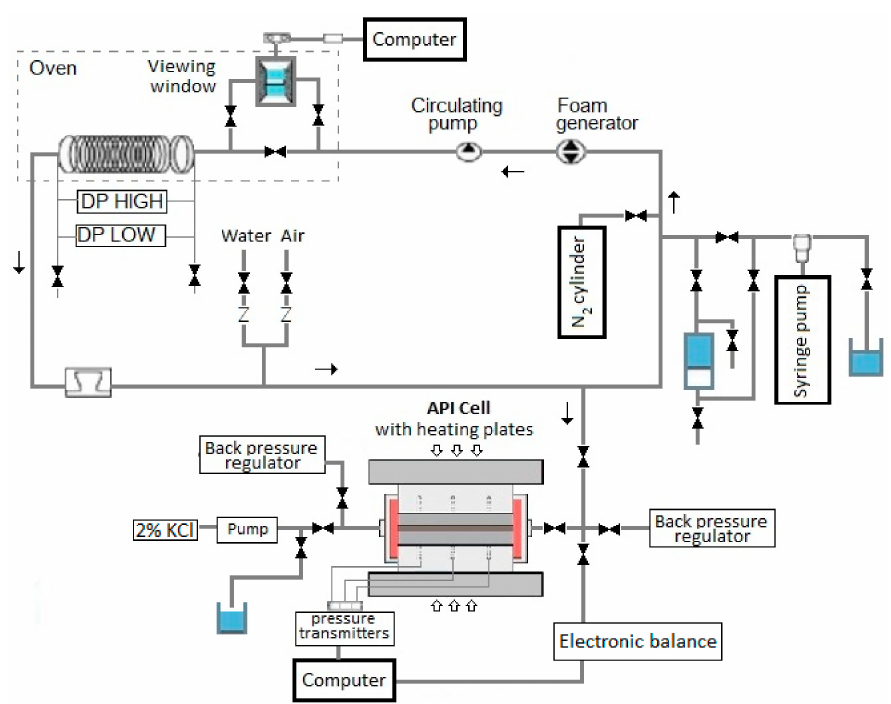
Figure 3. The simplified diagram of the measurement unit for testing the fracture conductivity and damaging it by foamed fracturing